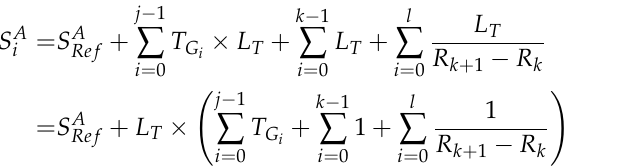
Figure 7. Locating algorithm of guideway inspection data (single side).